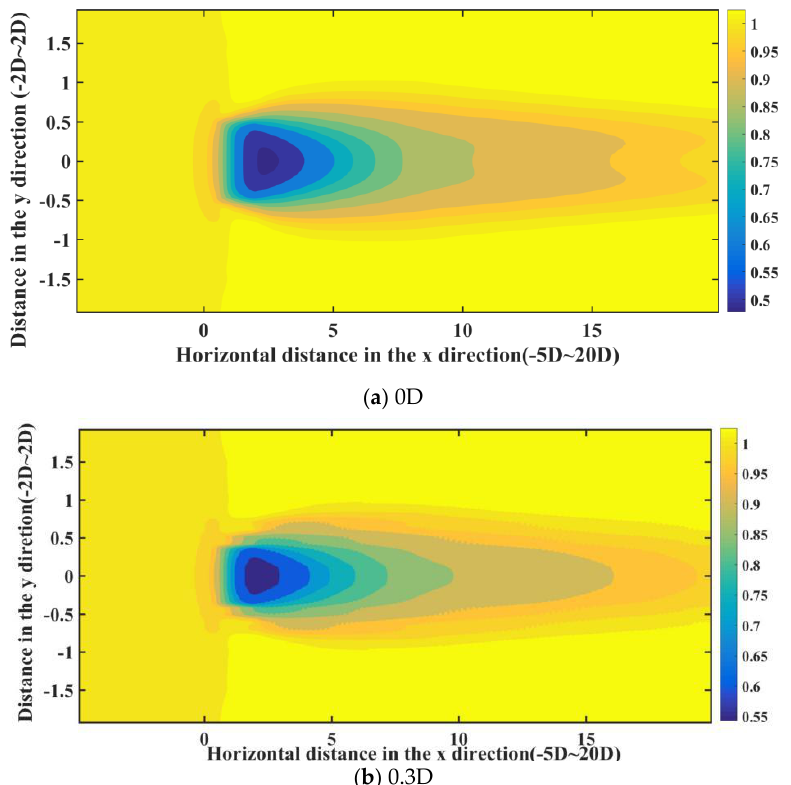
Figure 11. Wake velocity clouds on the neutral layer of different heights.